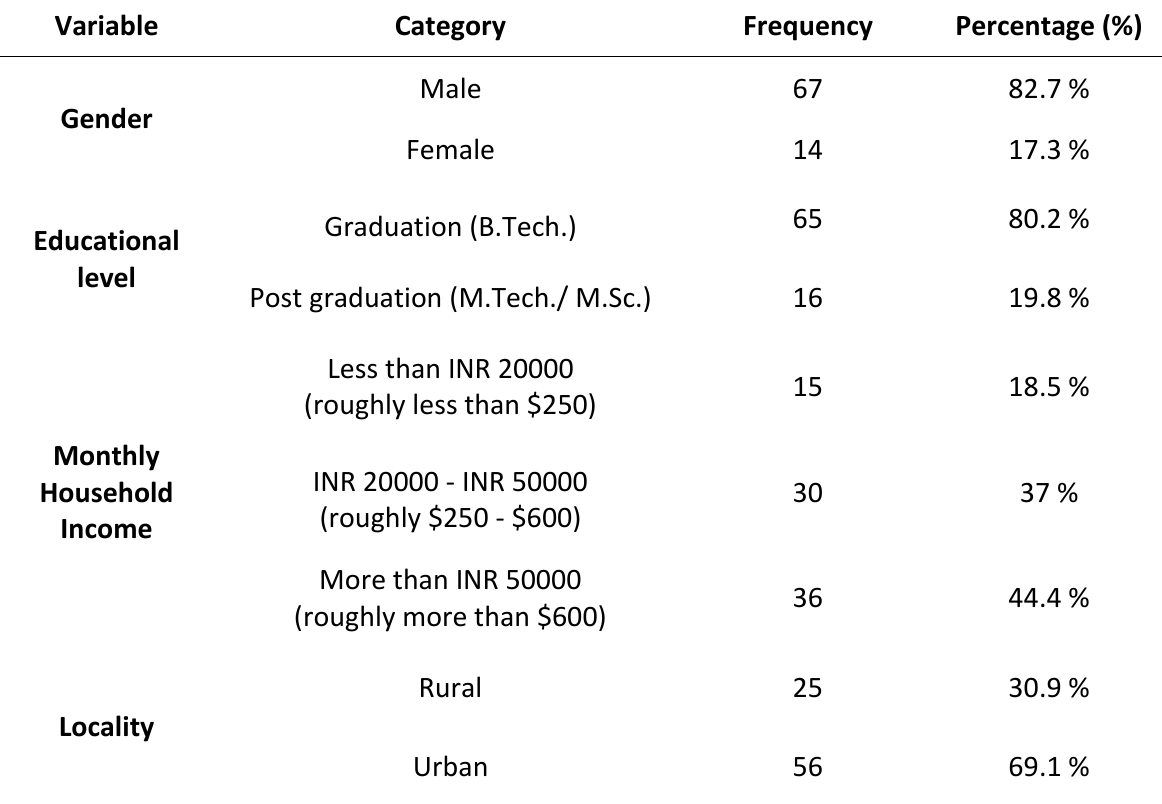
Table 2: Learners’ demographic characteristics from the ITLDE study (IIT Jammu)